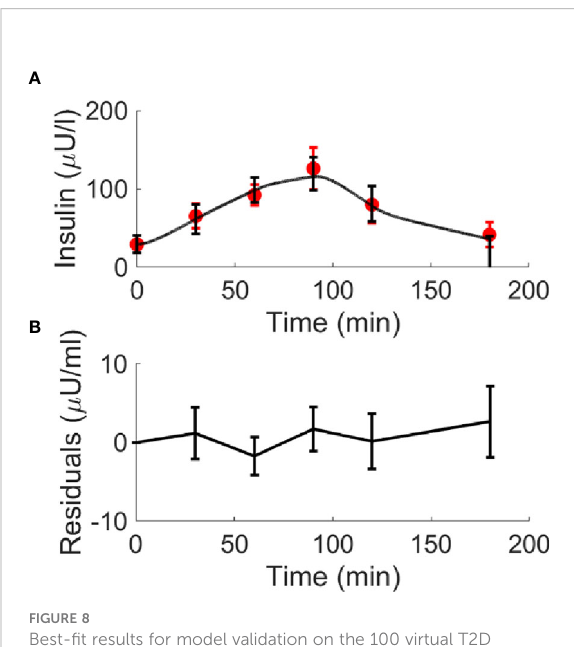
FIGURE 8 Best- fi t results for model validation on the 100 virtual T2D individuals. Red circles represent the mean (± SD) over the 100 individuals, whereas black continuous line represents the mean predicted insulin curve (panel A ); mean residuals over the 100 curves are also reported (panel B